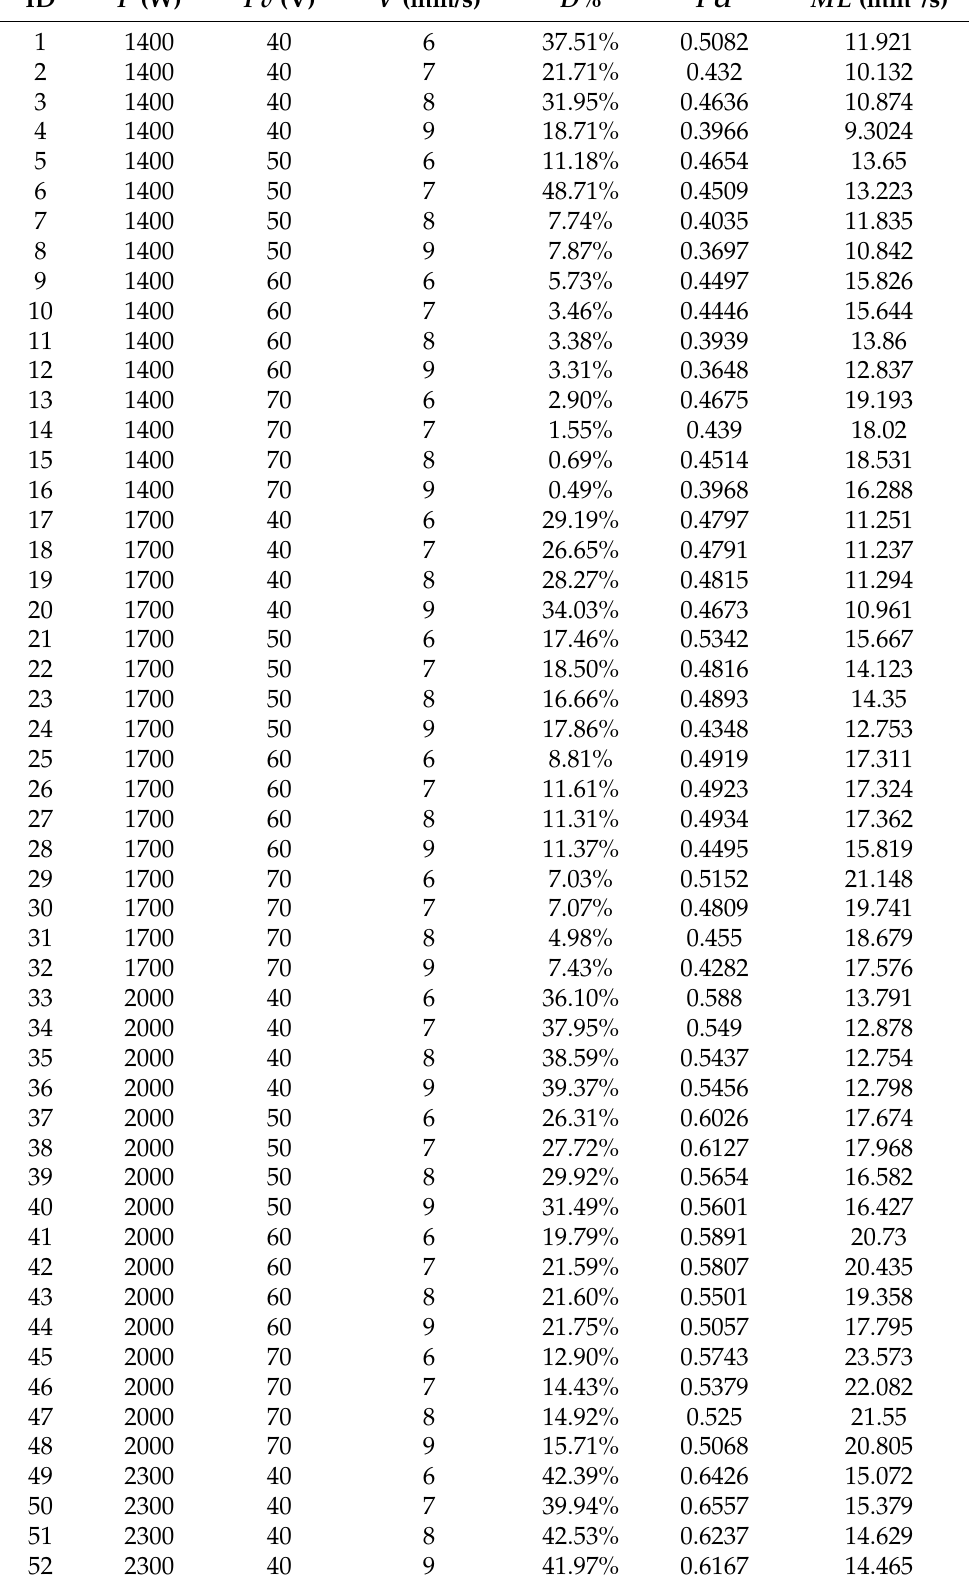
Table 2. Machining parameters and measurement results for each single